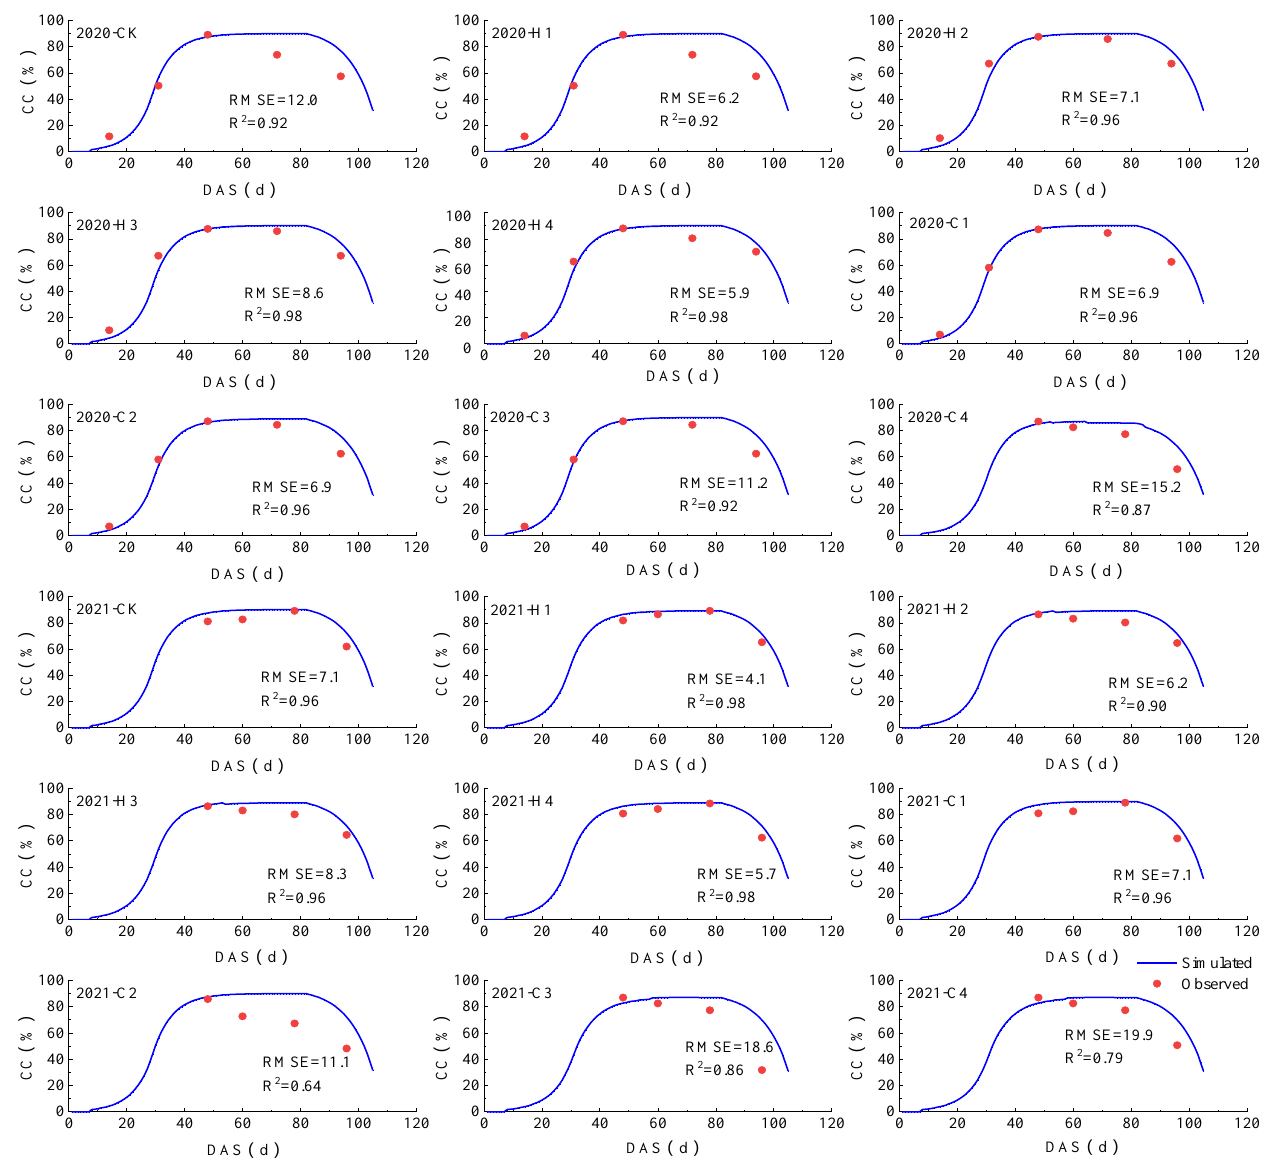
Figure 2. Simulated and observed canopy coverage curves of maize under all treatments in 2020– 2021. CC is the canopy coverage of maize, and DAS is the days after